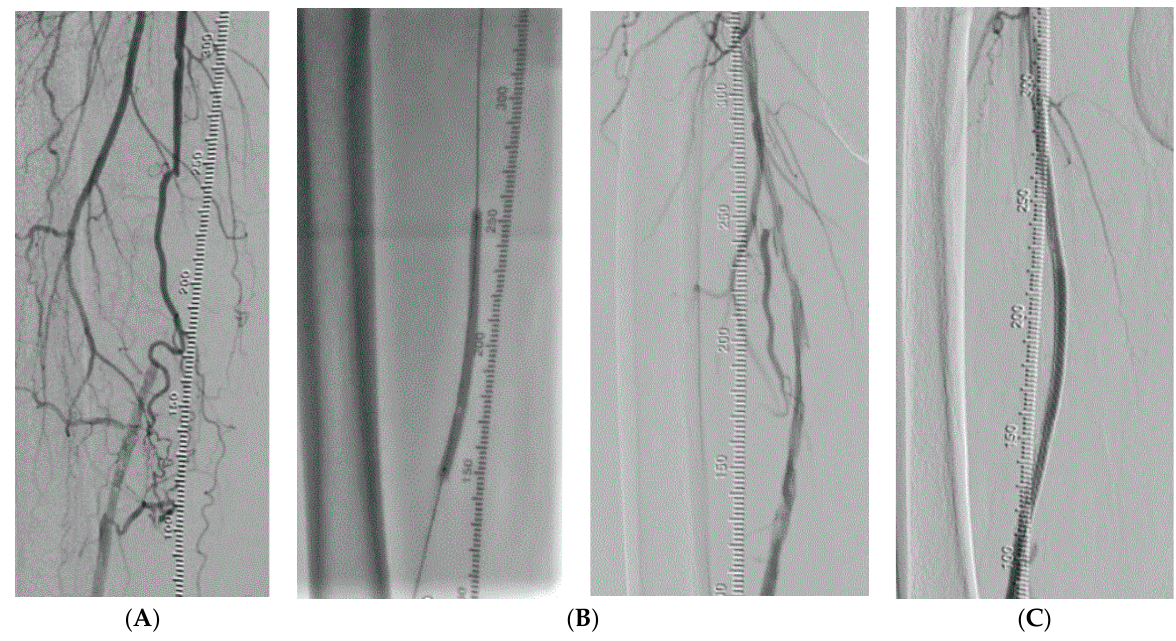
Figure 5. Vessel preparation and treatment. ( A ) Femoropopliteal occlusion. ( B ) Vessel preparation and control. ( C ) Final result with